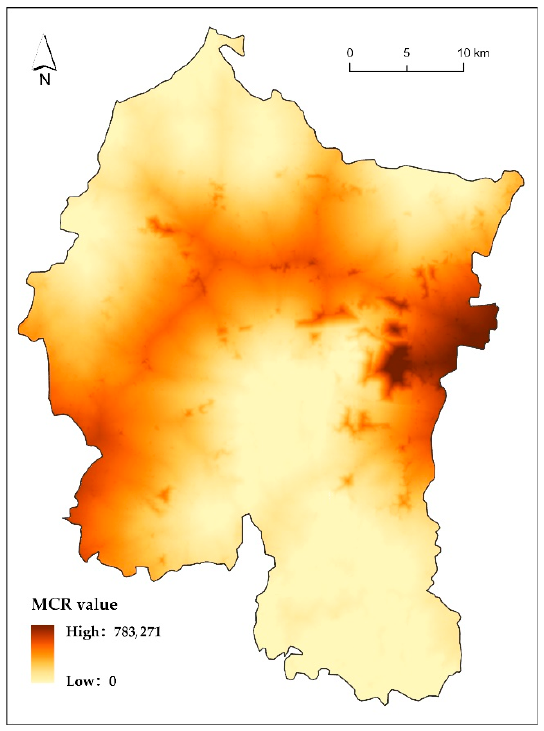
Figure 10. Minimum-cumulative-resistance